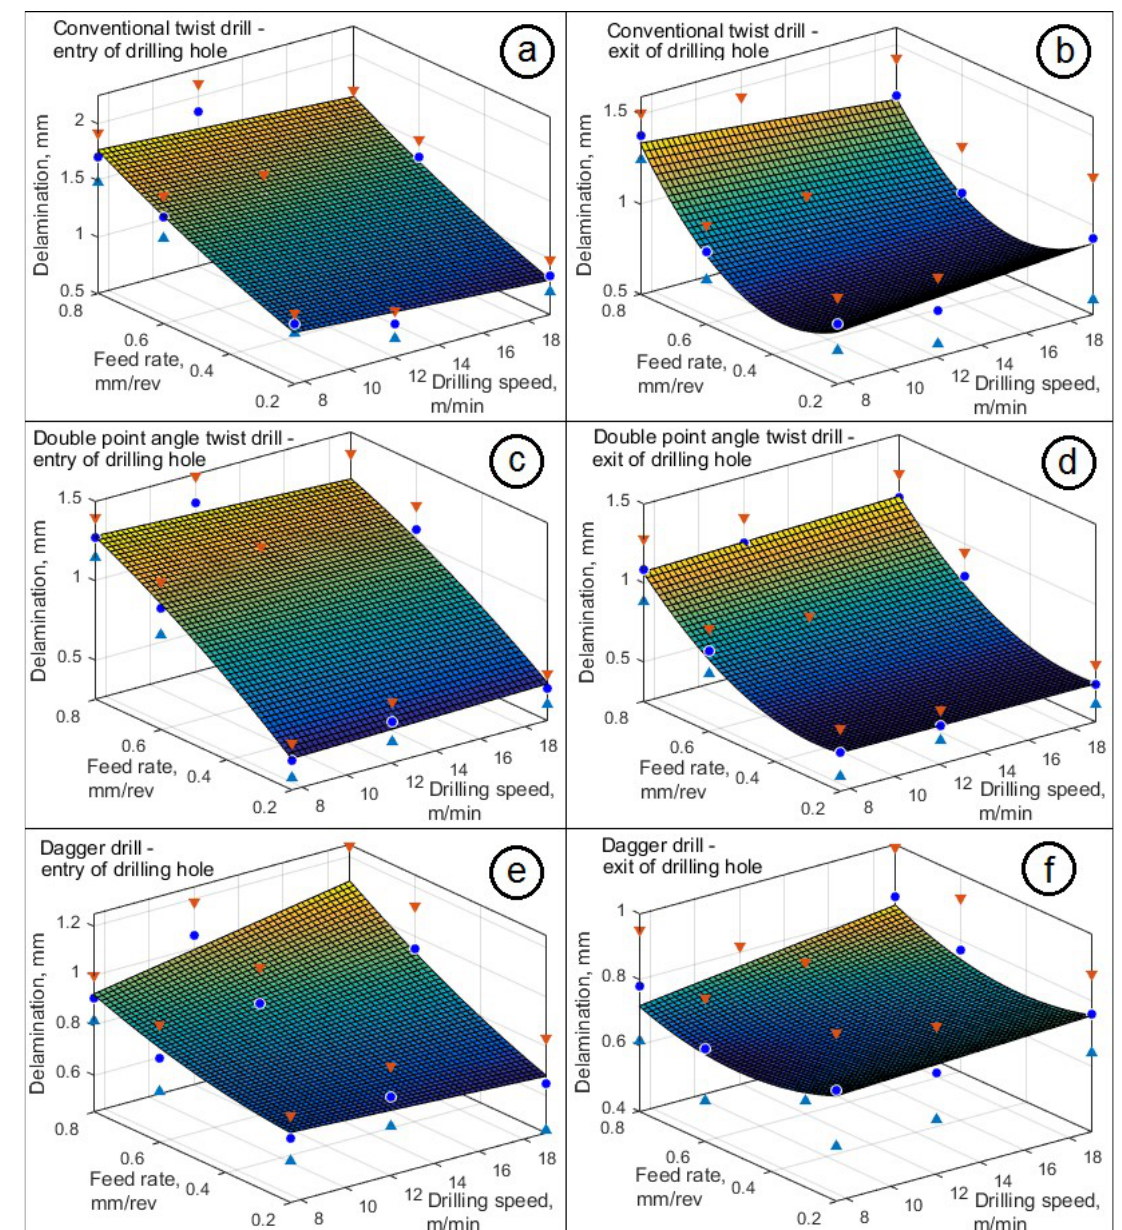
Figure 4. Three-dimensional plots of delamination values at the entry of drills into the hole ( a , c , e ) and at the exit from the hole ( b , d , f ) for a conventional twist drill ( a , b ), a double-point angle twist drill ( c , d ) and a dagger drill ( e,f ) represented as second-order polynomial-fitted response surfaces combined with the delamination mean values ( ), upper ( ), and lower ( ) bounds of the confi- dence intervals for each process test.